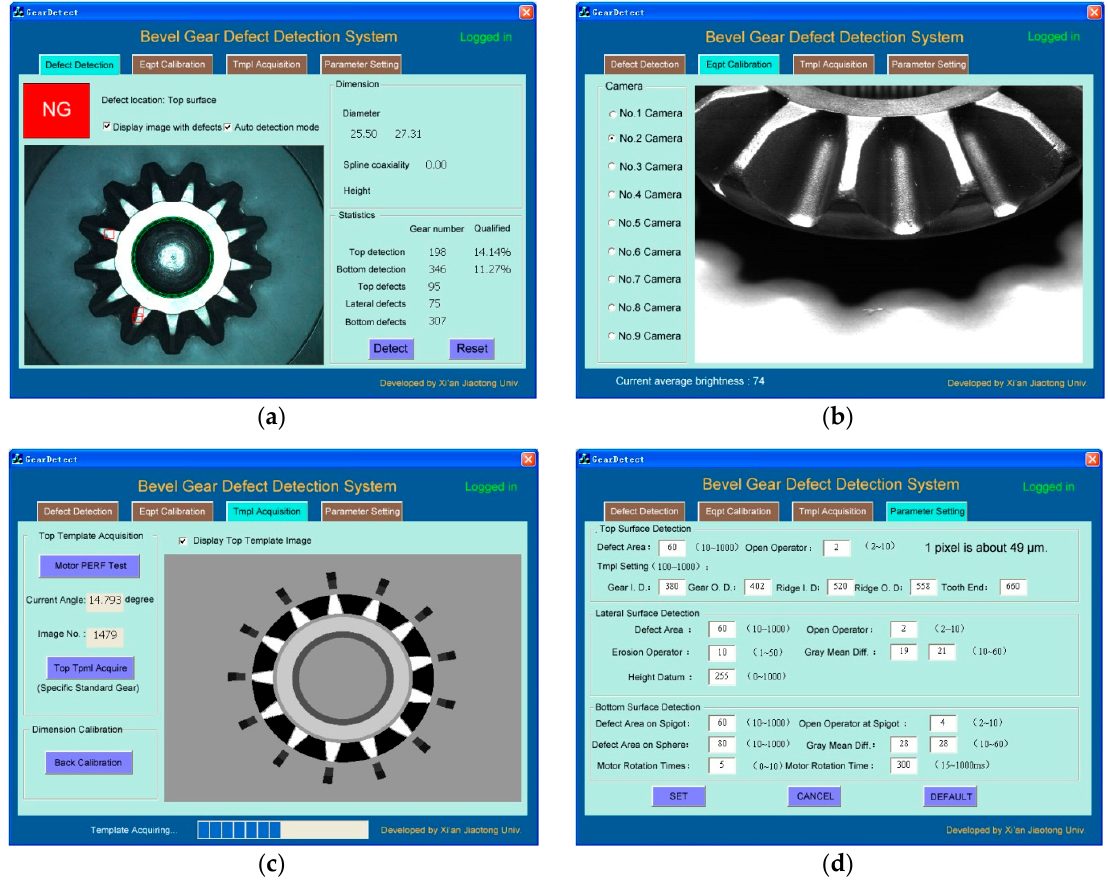
Figure 8. Soft interface of bevel gear inspection system: ( a ) Defect detection; ( b ) Equipment calibration; ( c ) Template acquisition; ( d ) Parameter setting.